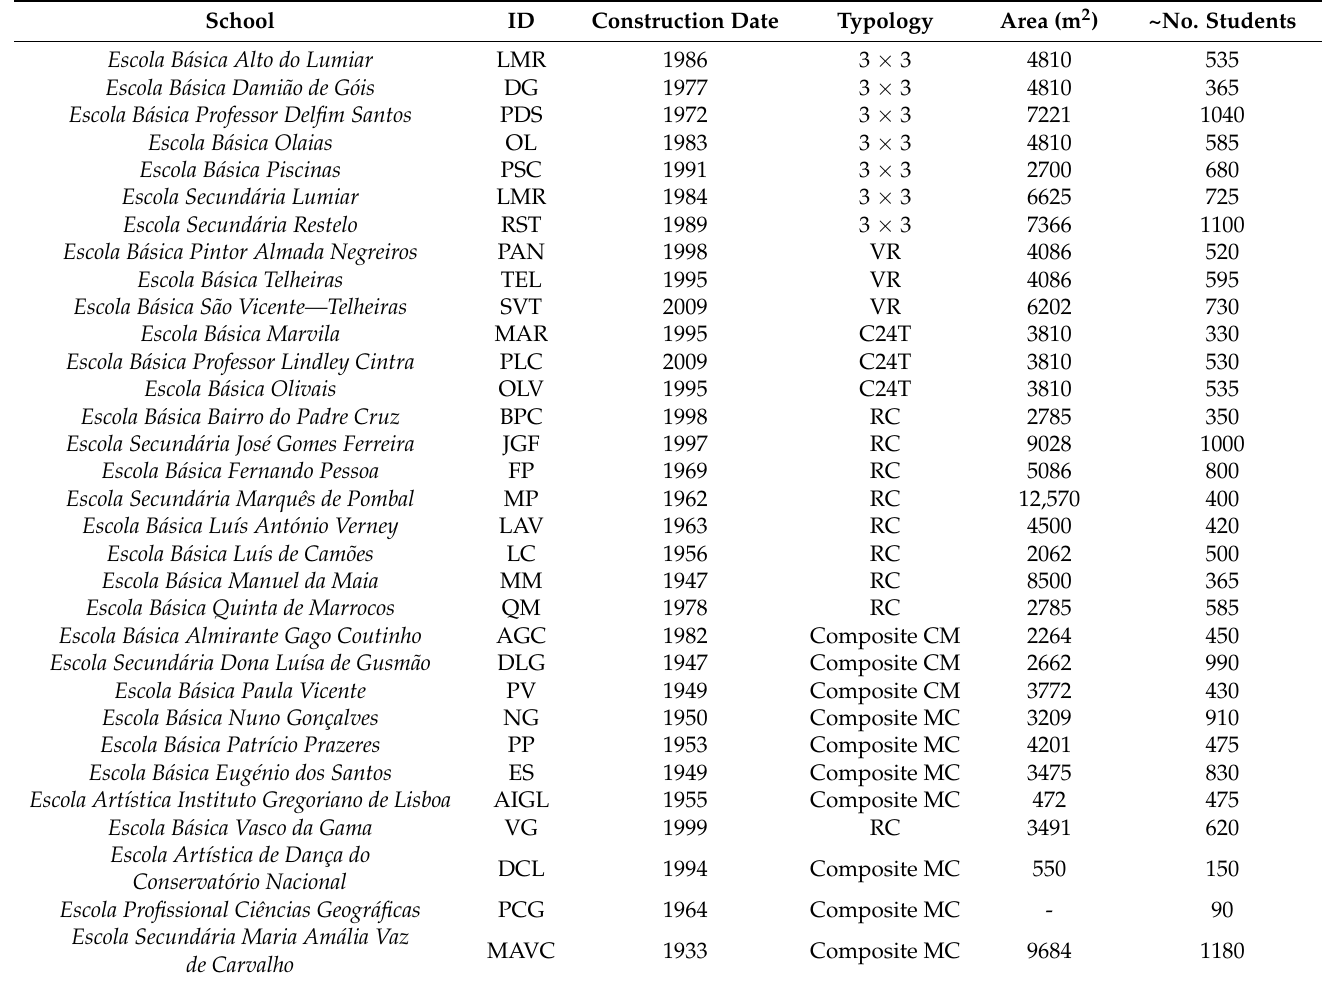
Table 2. Structural typologies and basic information of the 32 school buildings under